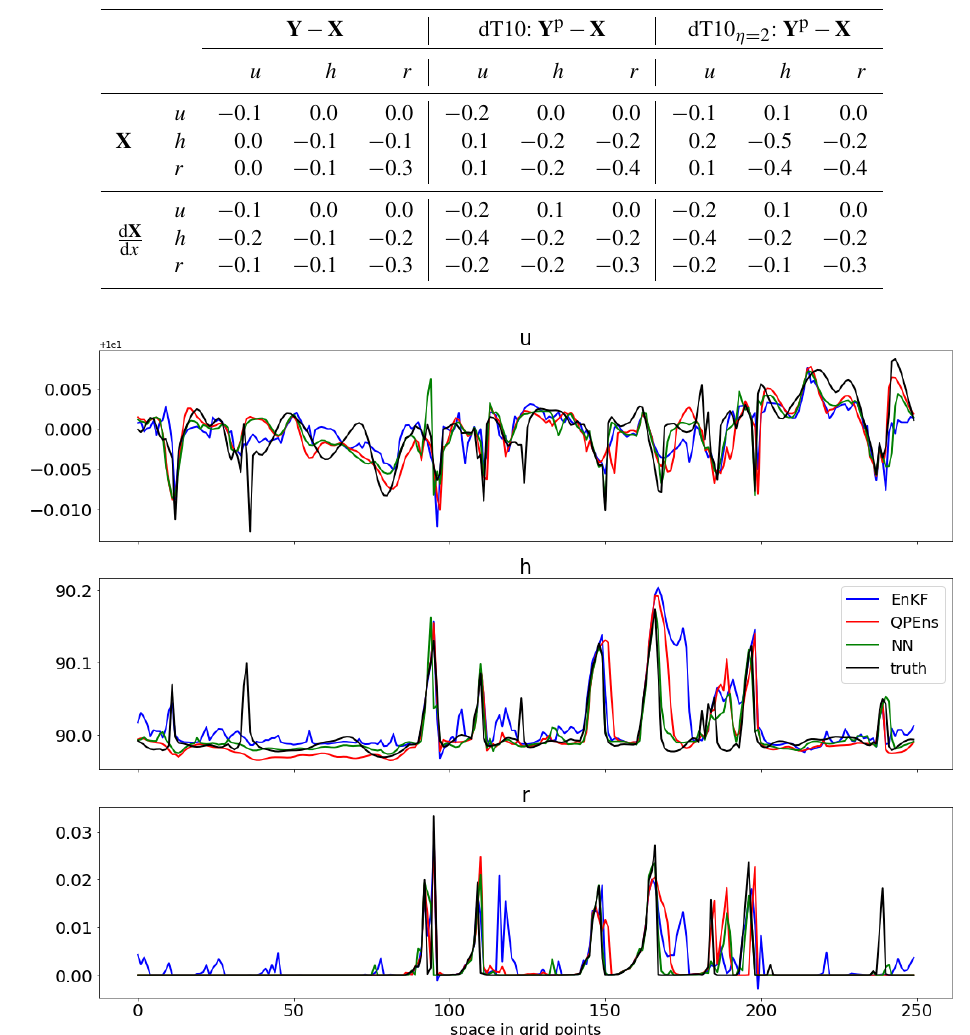
Figure 8. Truth (black) and ensemble mean snapshot for EnKF (blue), QPEns (red) and NN with dT10 η = 2 (green) before negative rain values are set to zero for the